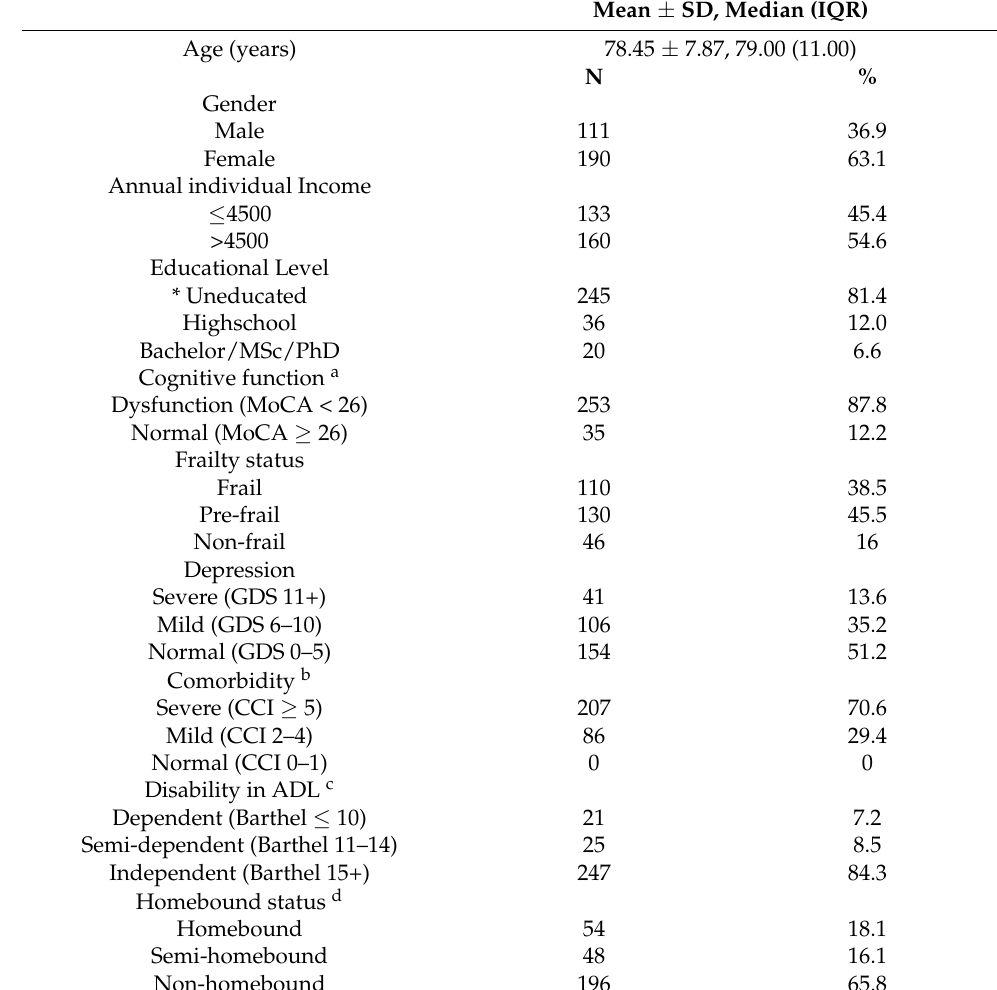
Table 1. Descriptive statistics of the study participants (n =